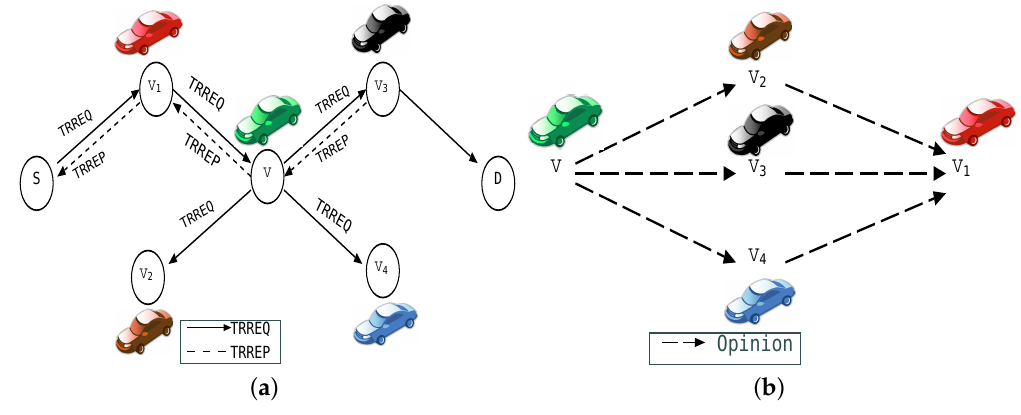
Figure 6. ( a ) General behavior of vehicles in performing trusted route discovery. ( b ) An example of trust recommendation from node V to node V 1